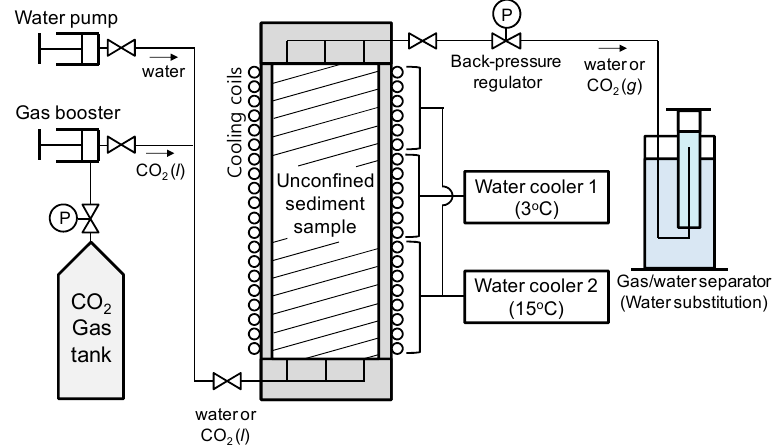
Figure 1. Conceptual drawing of the experimental design.